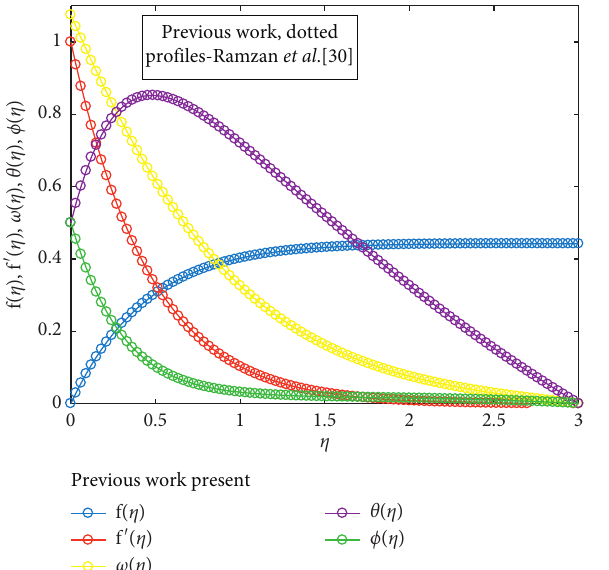
Figure 2: Validation of stream function, velocity, microrotation, temperature, and concentration profiles.